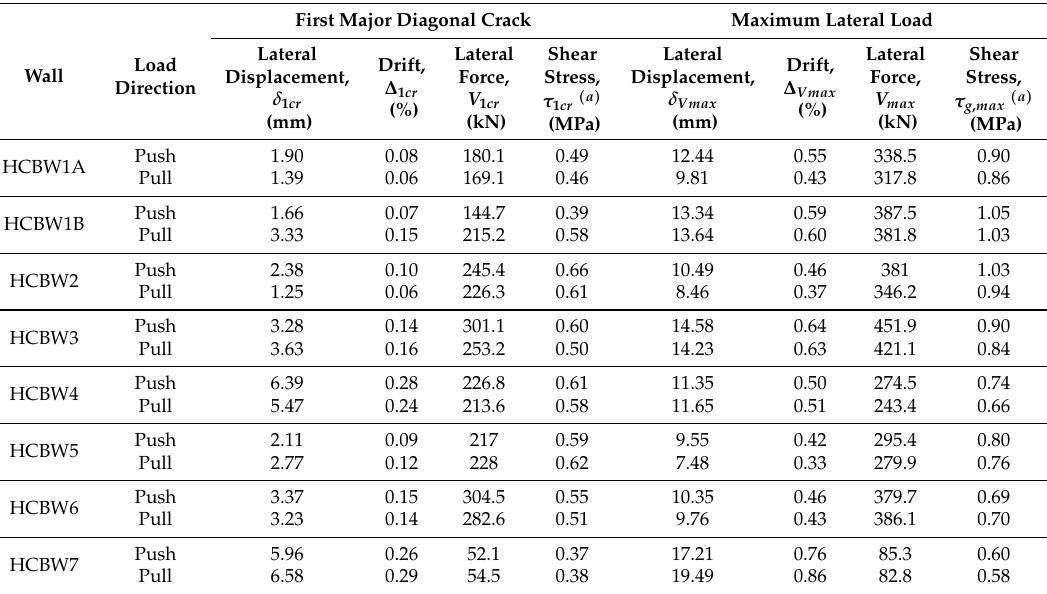
Table 4. Characteristic results of tested BJR-PG-RM